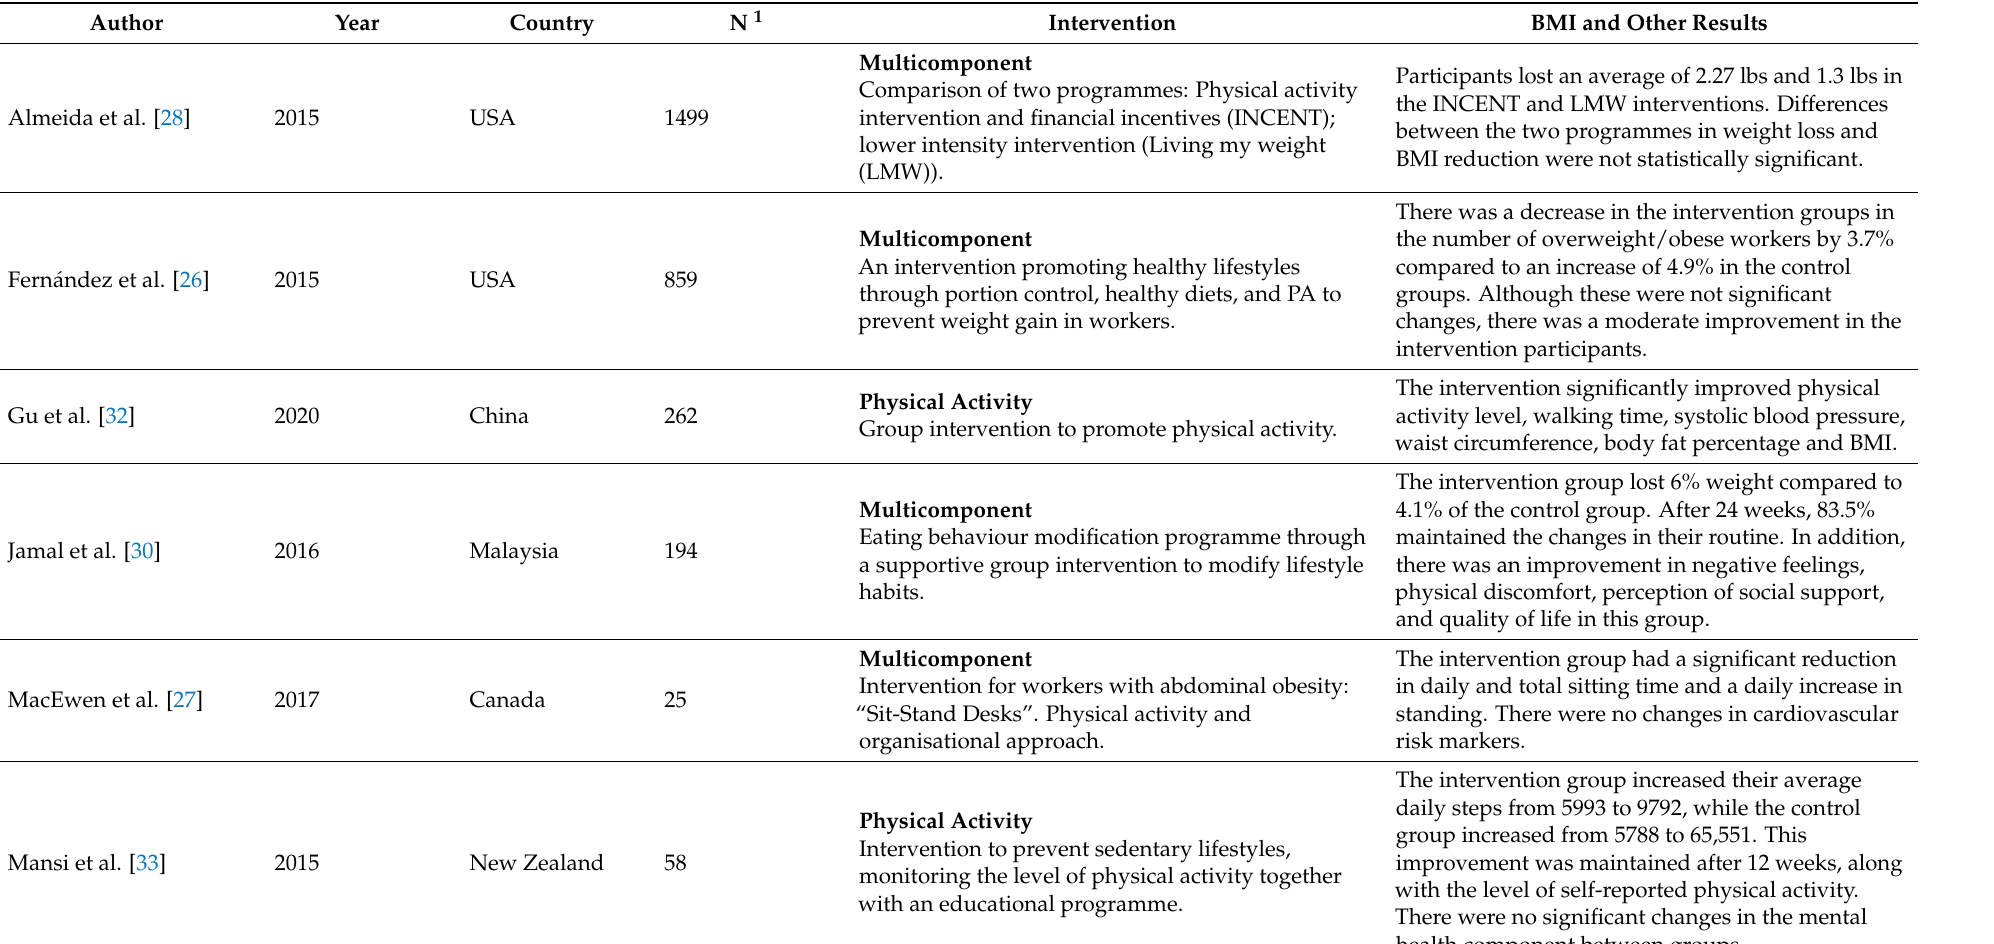
Table 1. Characteristics of the